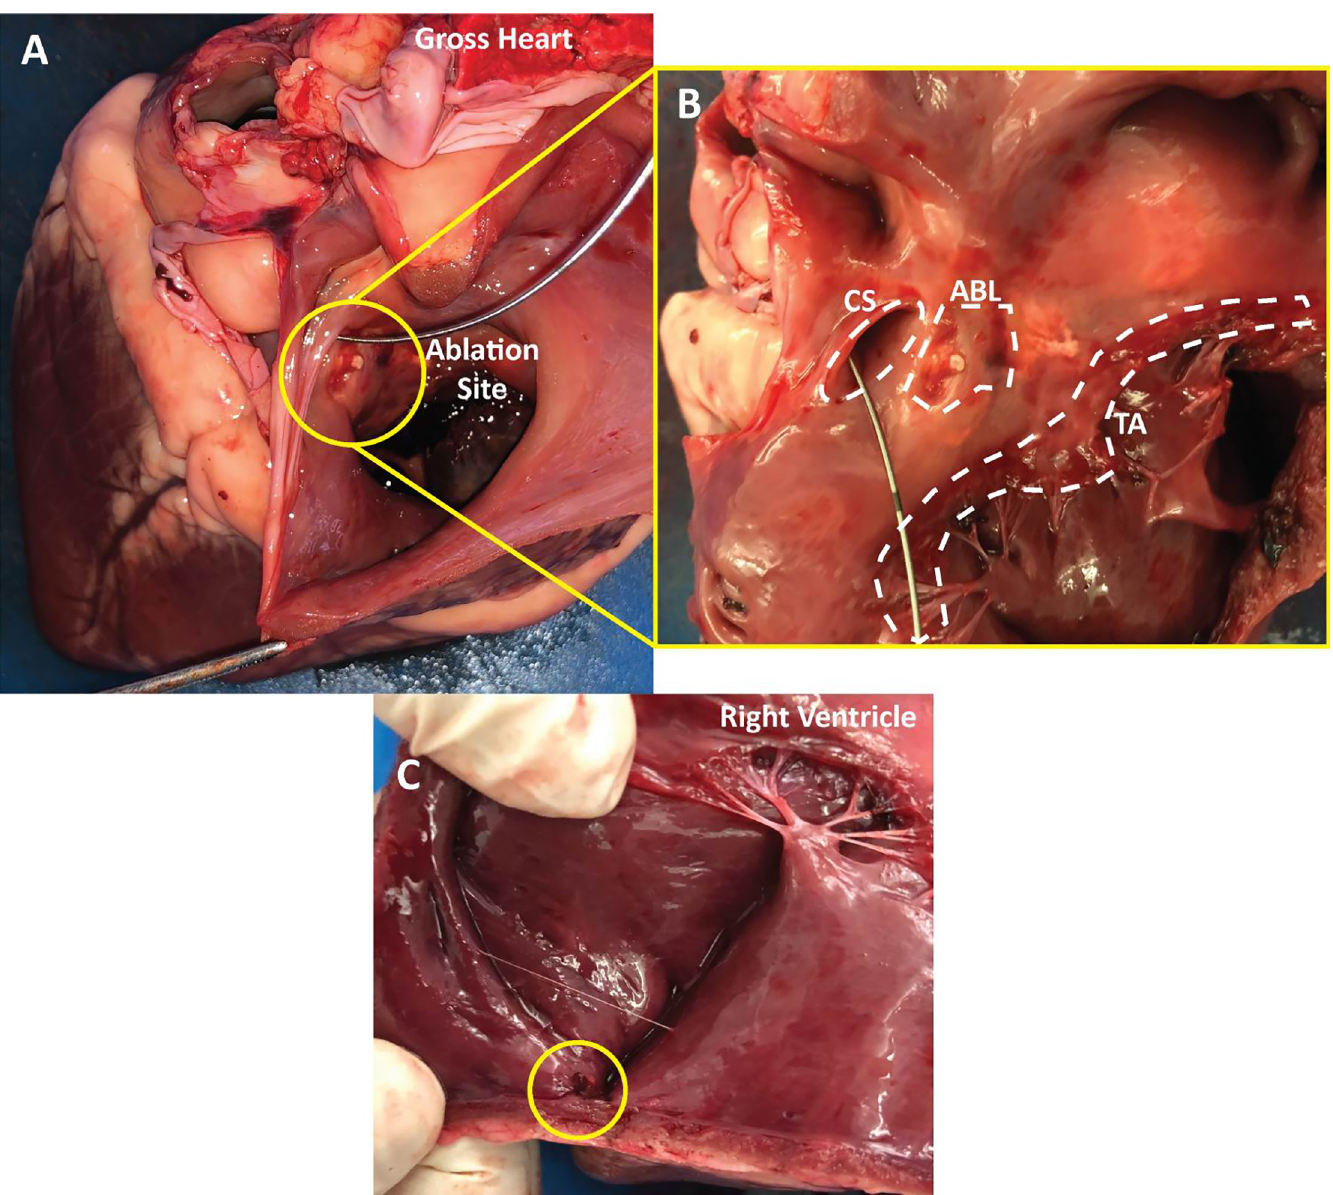
Fig 11. Gross anatomy of an explanted sheep heart showing landmarks, ablation lesions and lead attachment site. (A) This view depicts the gross heart anatomy with the view looking into the right atrium. The ablation site is shown within the circle. A wire was placed in the coronary sinus for orientation purposes. (B) Zoomed in perpendicular view of the coronary sinus (CS), tricuspid annulus (TA) and the ablation lesions (ABL). (C) View showing the lead attachment site within the circle at the apex of right